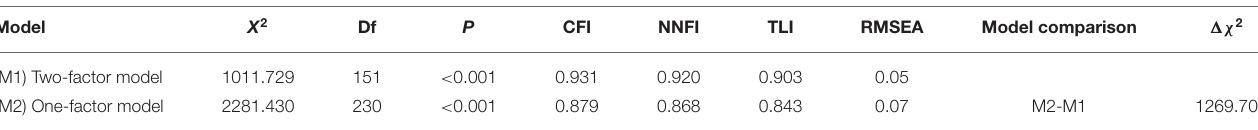
TABLE 4 | Summary of model fit